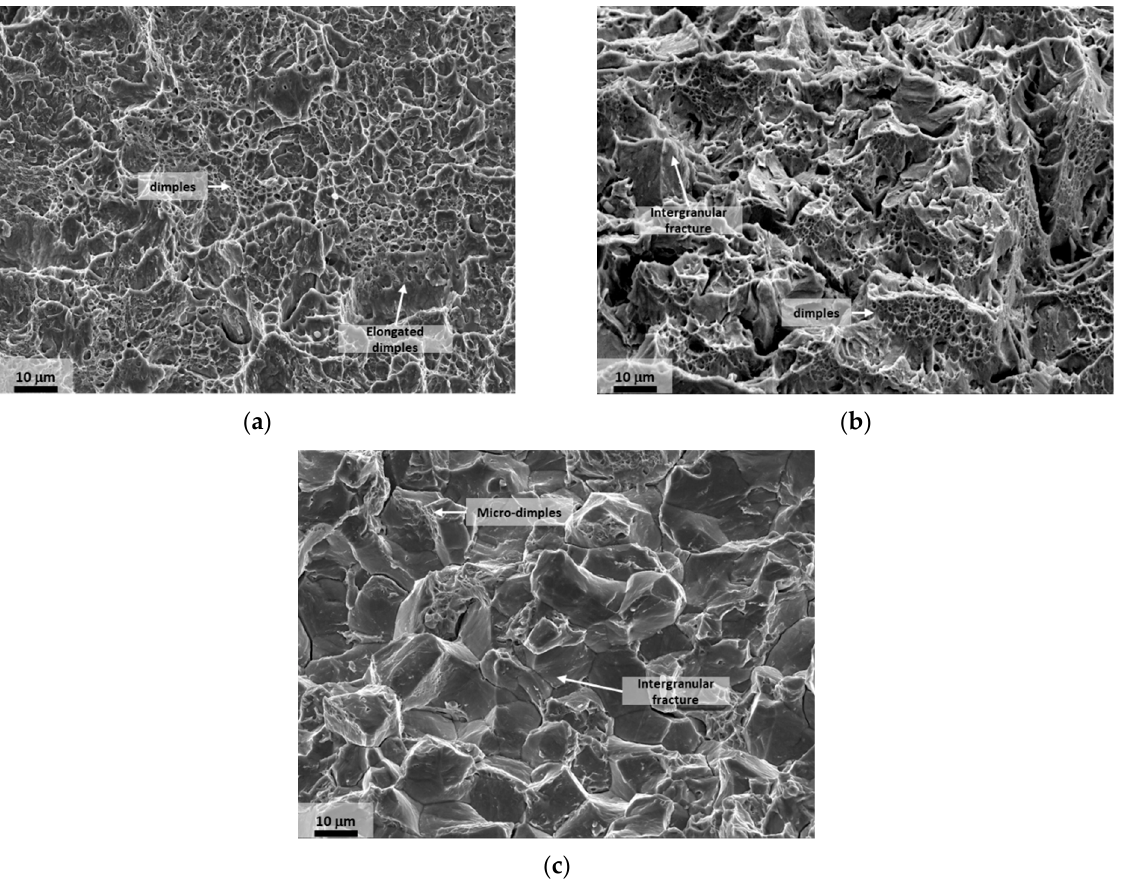
Figure 12. Fracture surface of tensile samples. ( a ) QP-321, ( b ) QP-371, ( c ) QP-421.